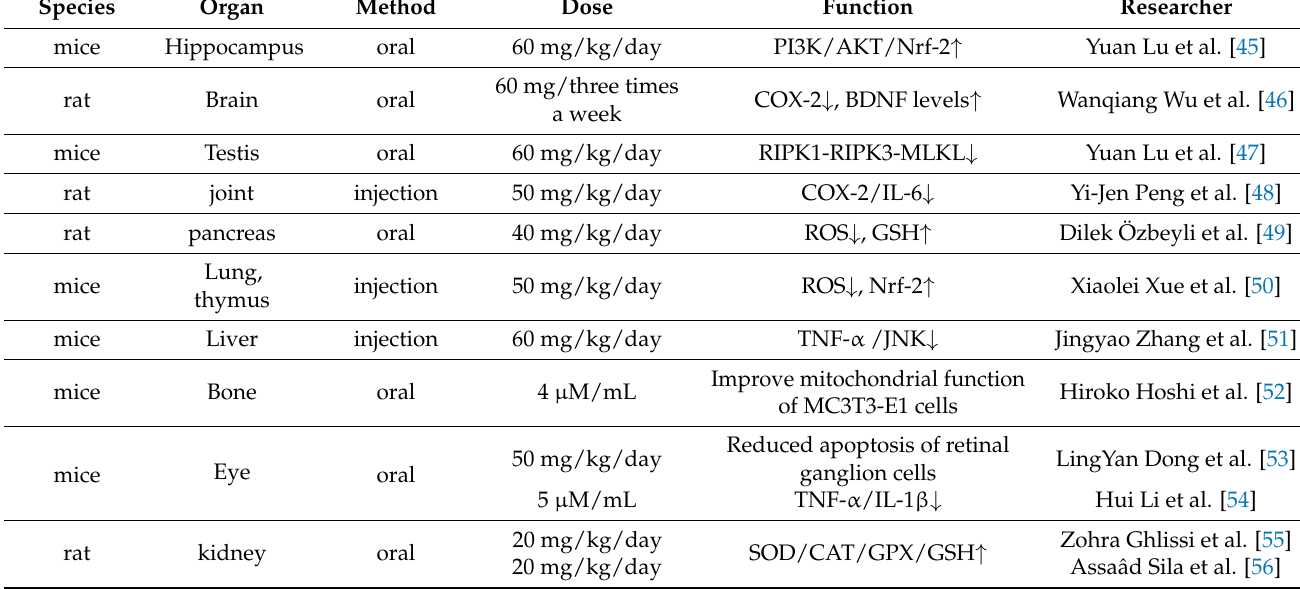
Table 1. Current research of astaxanthin in the field of biomedicine.